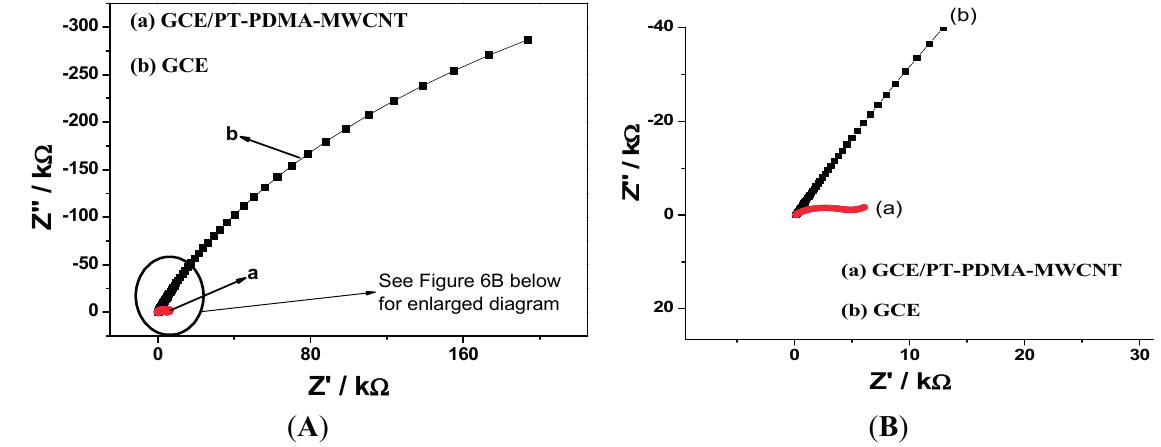
Figure 6. ( A ) Nyquist plots of GCE/PT-PDMA-MWCNT (a) and GCE (b) in PBS at 0 mV; ( B ) Enlarged Nyquist plots of GCE/PT-PDMA-MWCNT (a) and GCE (b) in PBS at 0